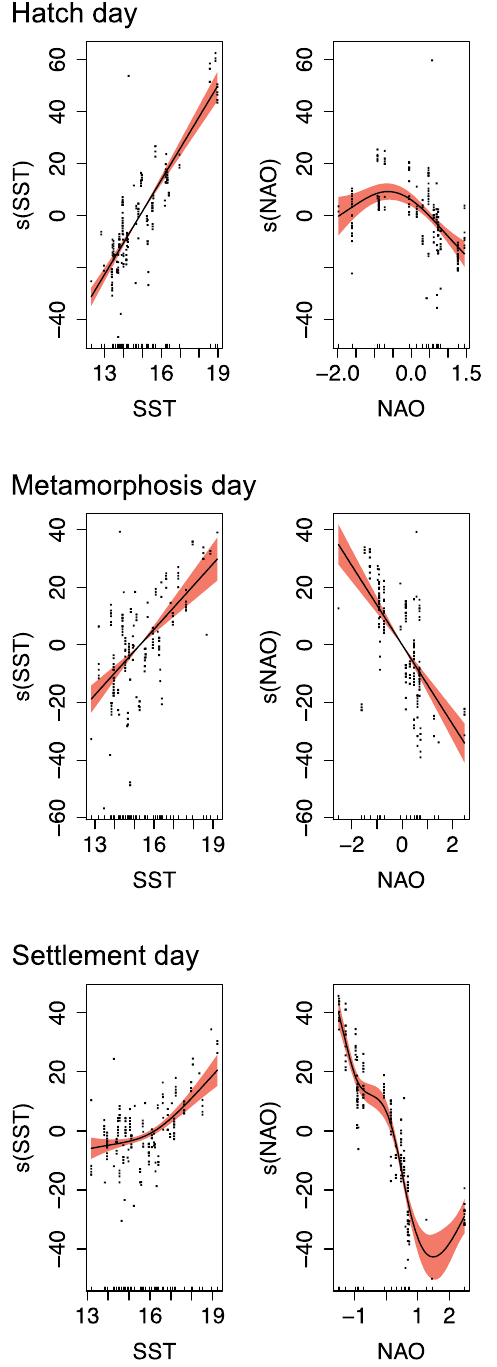
Figure 7. Generalized Additive Models (GAM) smoother response curves of the environmental drivers explaining the variation in Solea solea hatch, metamorphosis, and settlement day for the period between 2010 and 2015. SST—Sea Surface Temperature (°C); NAO—North Atlantic Oscillation. Black dots depict the partial residuals for each term. The uncertainty bands denote the 95% confidence intervals for each